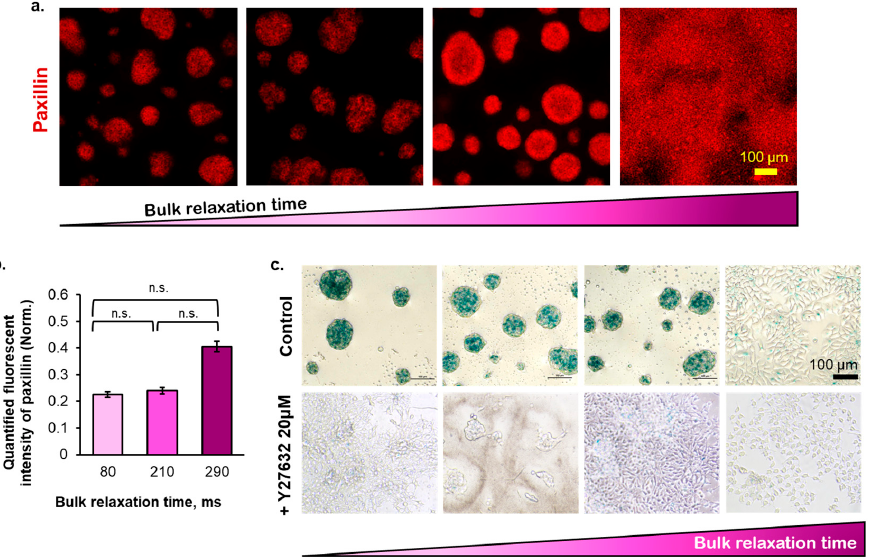
Figure 3. ( a ) The immunofluorescence-stained images of the cells on day 5 for paxillin, ( b ) the quantified expression of paxillin on day 5 (normalized to the paxillin expression in control substrate, polystyrene), and ( c ) the expression of chromogenic senescence marker (SA- β -Gal) with various condition (untreated, or treated with a ROCK inhibitor, Y27632). (Statistical analyses: Student’s t -test n.s. p >